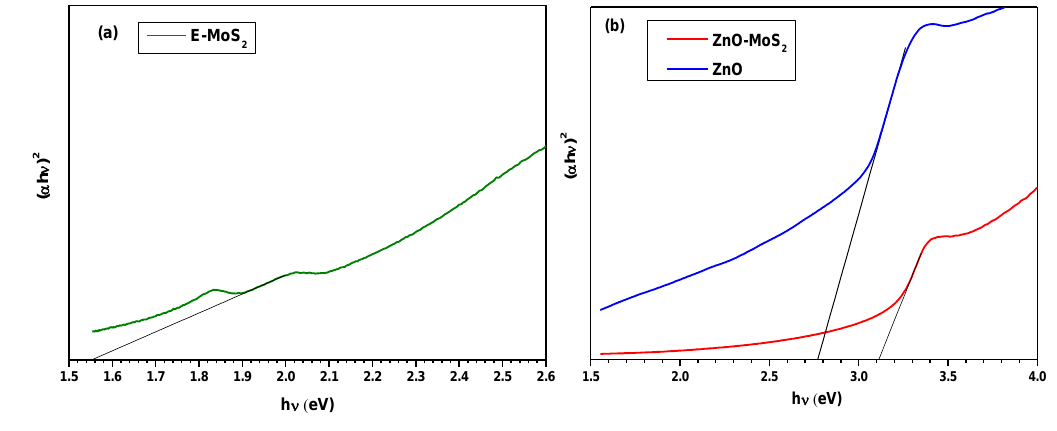
Figure 5. ( a ) Tauc plot for E-MoS 2, ( b ) Tauc plot for ZnO and ZnO-MoS 2.